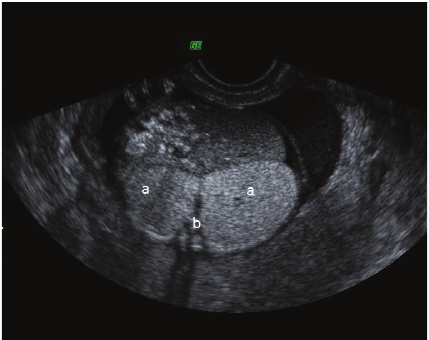
Figure 2: Antenatal MRI of case 1 showing dilated airways (arrow), hyperxpanded lungs, inverted diaphragm, and ascites.